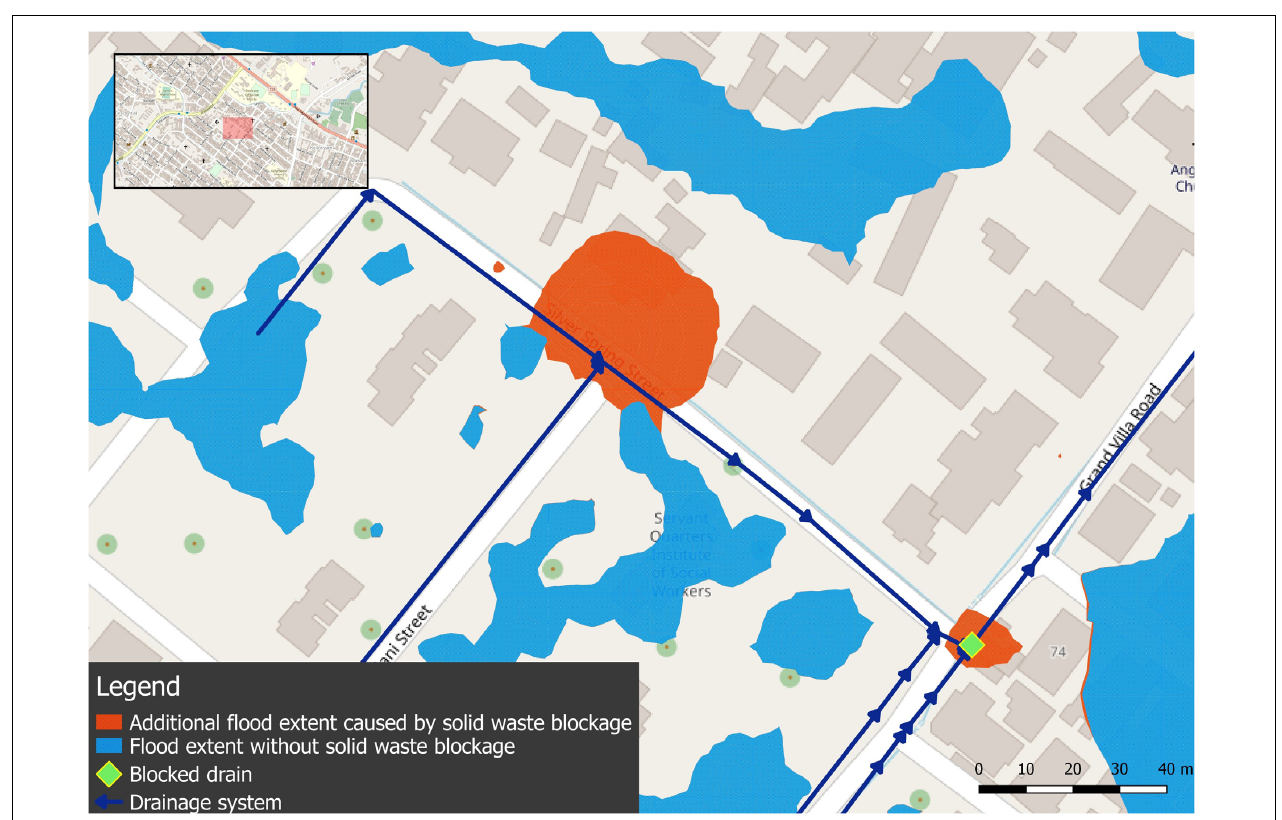
FIGURE 7 | Additional surface flooding caused by blocked drainage